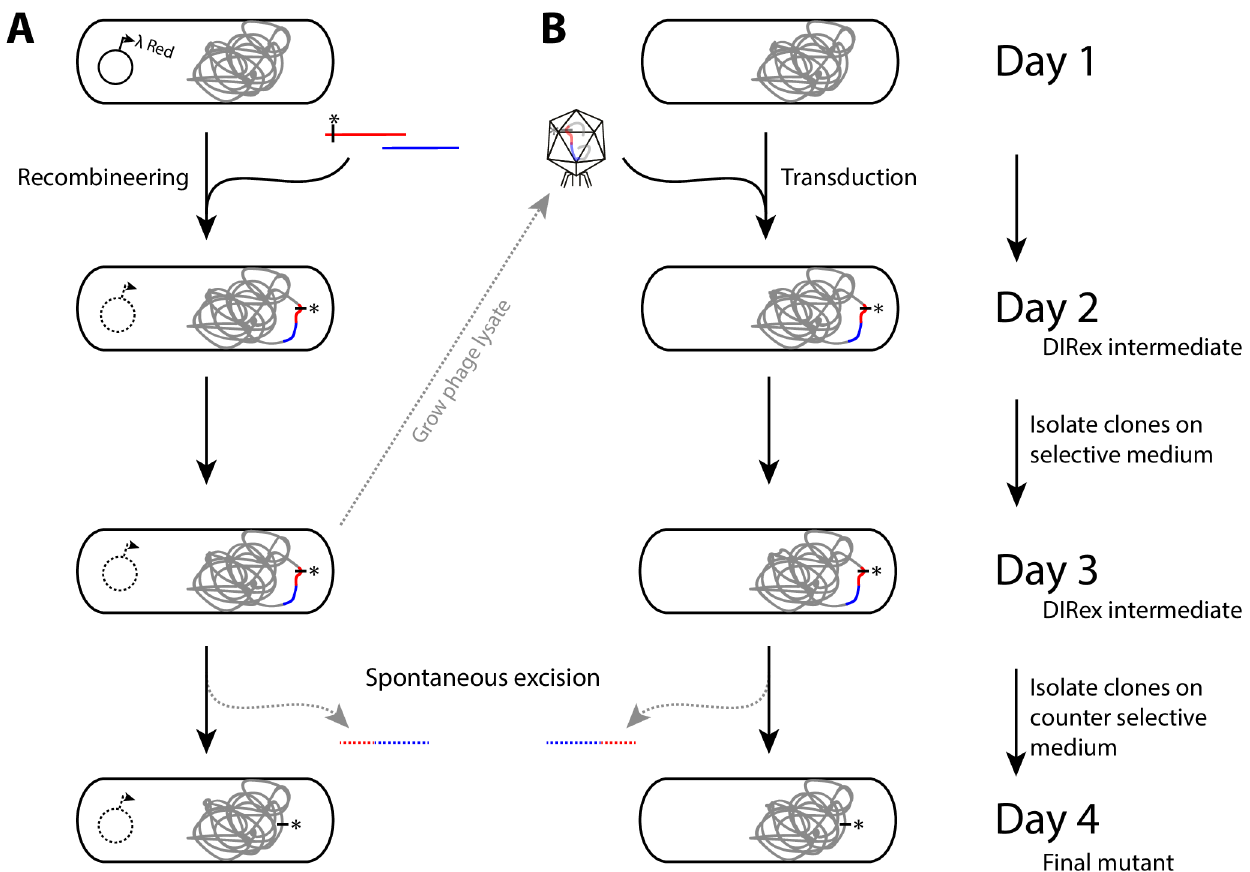
Fig 1. Outline of the method. (A) Generation of a designedmutation in three days using DIRex. (Day 1) A culture expressing λ Red is transformed with two PCR products to generatea semi-stable DIRex intermediate containing a selectableand counter selectablecassette. See Fig 2 for more details. (Day 2) Transformants are isolated and colony-purified on selective medium.(Day 3) Coloniesgrowingon selective medium are picked and streaked on counter-selective medium. (Day 4) Nearly 100%of coloniesgrowingon counter selective media containthe designedmutation. (B) Transferringa previously constructed mutation into anotherstrain by generalized transduction. A phage lysate grown on a strain containing a DIRex intermediate is used as donor in the transduction. The steps involvedare the same as in (A) except for a transduction instead of a recombineering step on day